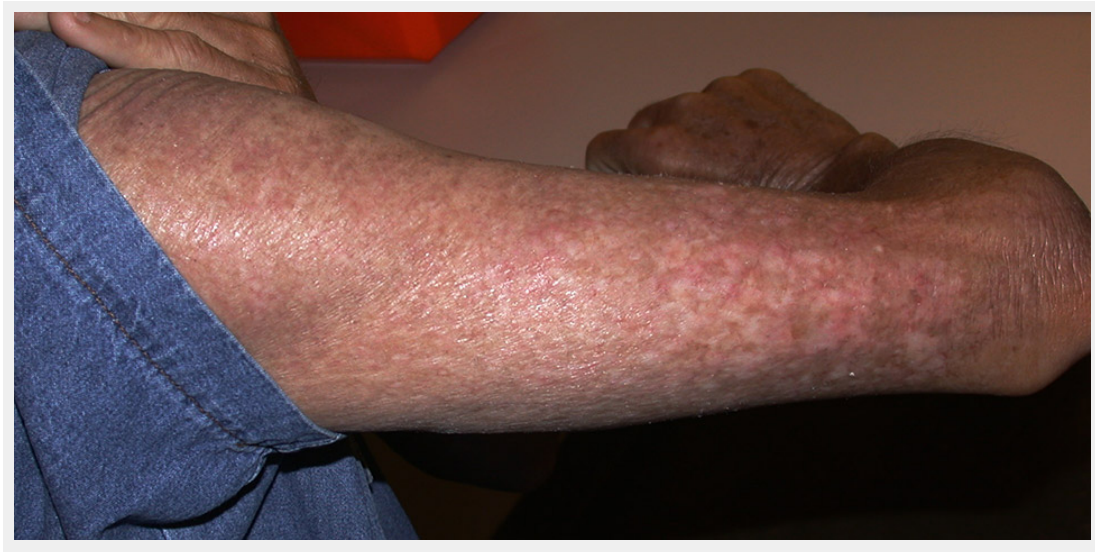
Figure 4B Lichenoid features and irregular pigmentation of chronic GvHD of the